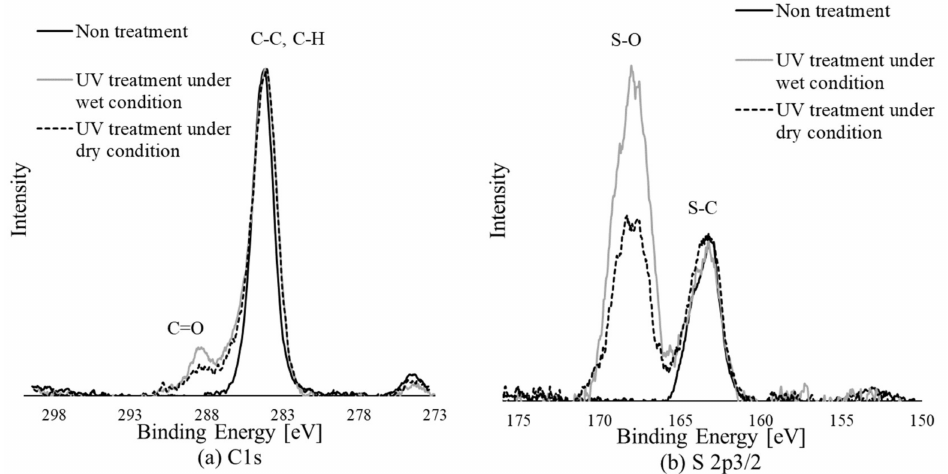
Figure 4. XPS spectra of each UV condition (A504X90B): ( a ) C1s spectra, ( b ) S2p3/2 spectra (wet conditions: 16.0 g/m 3 and dry conditions: 7.8 g/m 3 ).